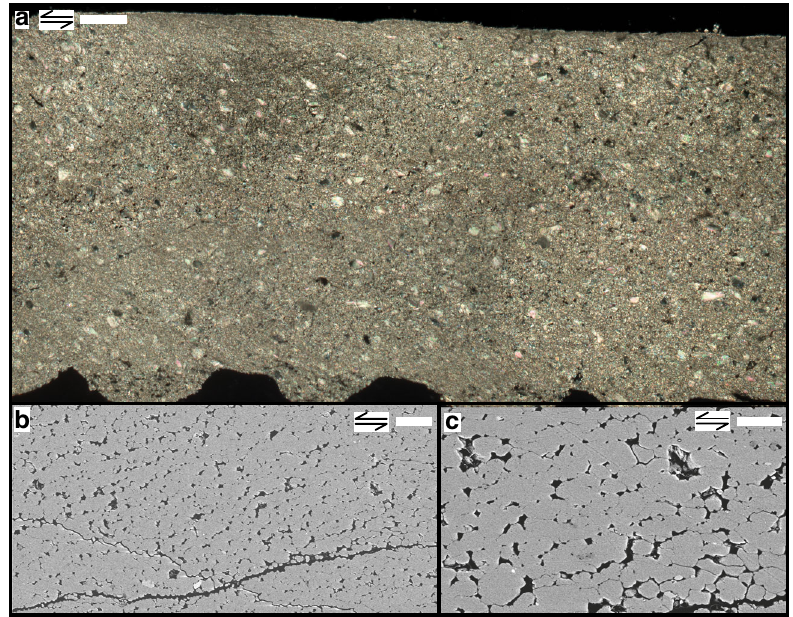
Fig. 2 Microstructure of simulated calcite fault gouge sheared at 550 °C at 0.1 μ m s − 1 . Double arrows indicate sense of shear. a Cross-polarized light micrograph. Scale bar, 100 µ m. b , c Backscatter electron micrographs, showing microstructures representative for the (relatively) homogeneously sheared gouge layer. Scale bars, 10 µ m ( b ) and 5 µ m ( c